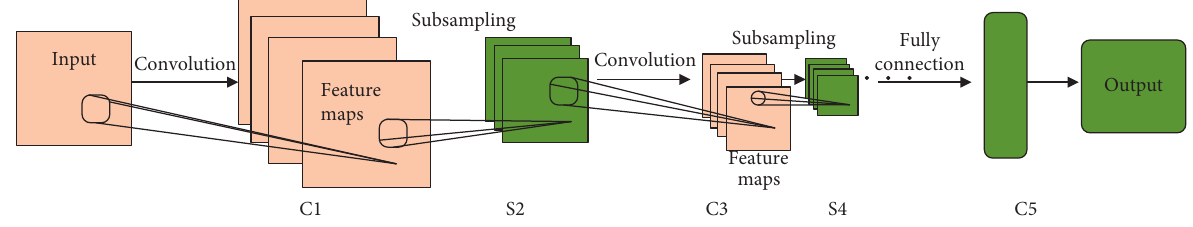
Figure 1: The classical network of convolutional neural networks